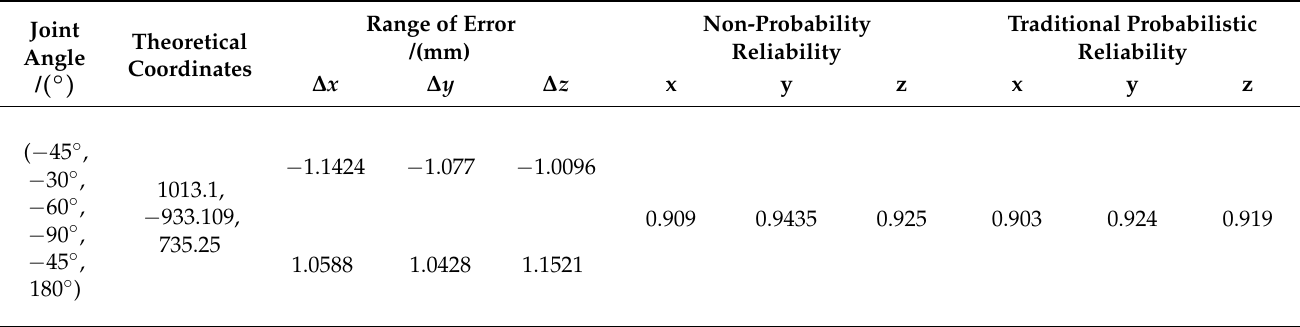
Table 4. Comparison data of positioning accuracy and